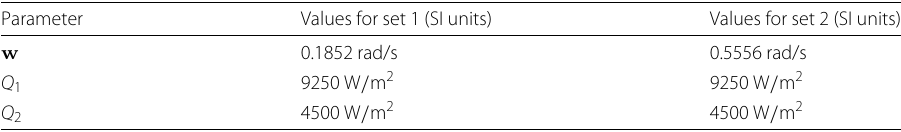
Table 1 Used experimental parameters